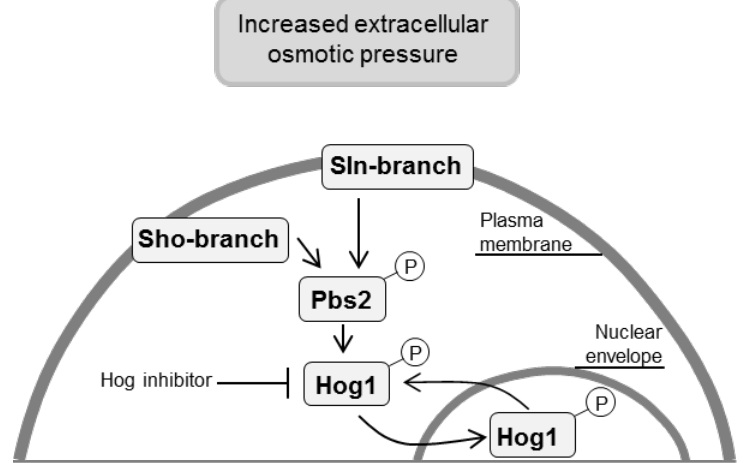
Figure 1. A simplified scheme of the HOG signaling pathway. The HOG pathway responds to changes in external osmolarity. The activation signal is transduced via the Sln1 and Sho1 branch respectively, that merge by the phosphorylation of the MAPKK Pbs2. Pbs2 subsequently phosphorylates and activates the MAPK Hog1, which rapidly translocates from the cytoplasm into the nucleus. The inhibitor acts on Hog1 and will inhibit its downstream kinase